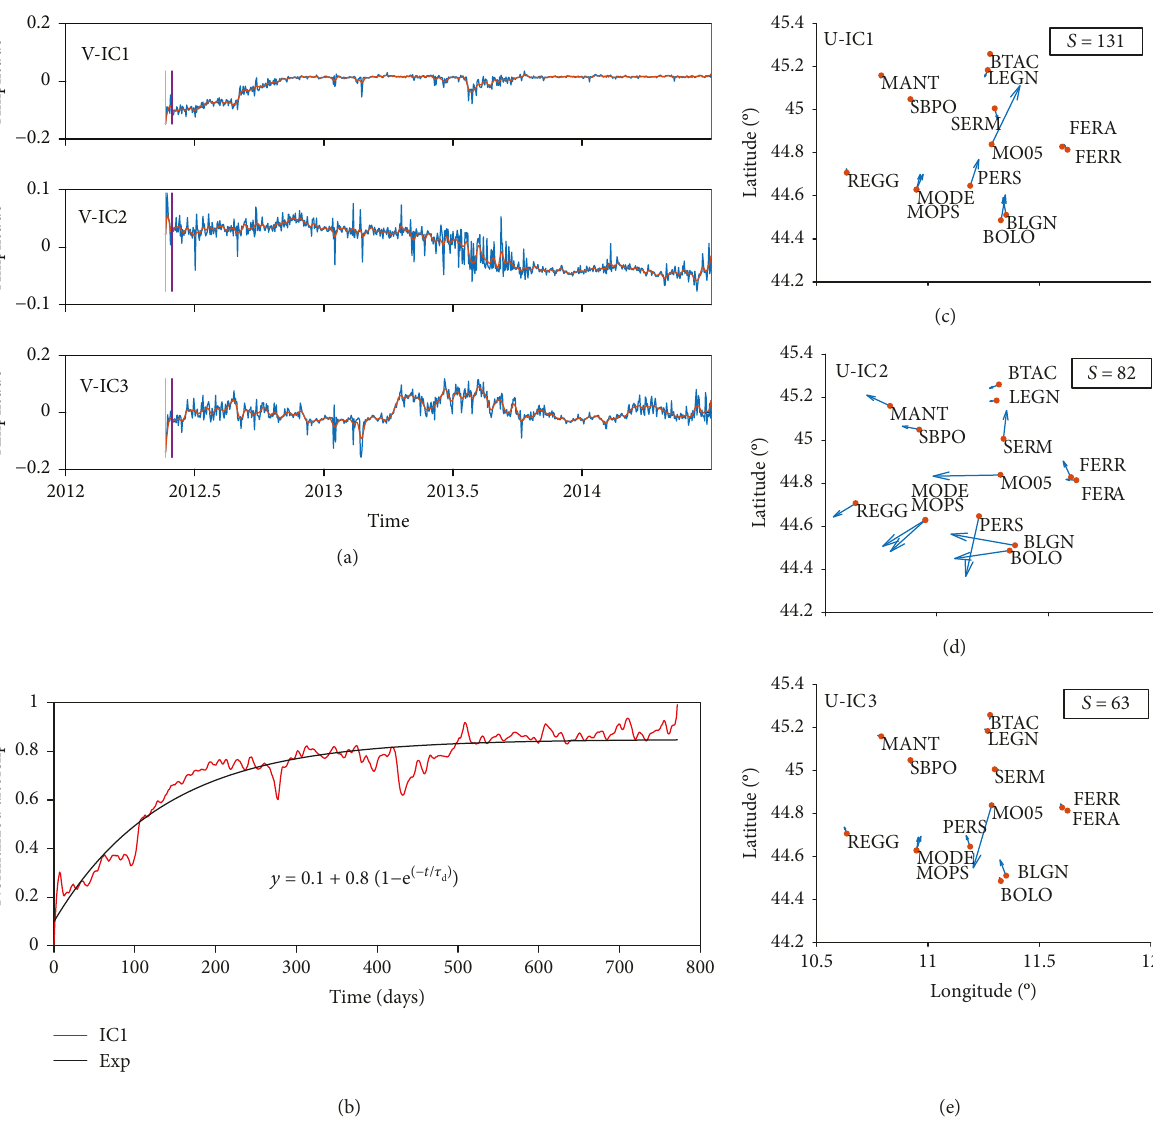
Figure 2: (a) Blue: temporal evolution ( V ) of the three independent components (ICs) necessary to reproduce the horizontal GPS position time series. Red: low-pass fi ltered temporal functions V . (b) Normalized V1, interpreted as exponential afterslip (black curve). (c – e) Horizontal spatial distribution ( U ) of the three ICs, where S is a weight coe ffi cient (in mm) necessary to rescale each IC contribution in explaining the original